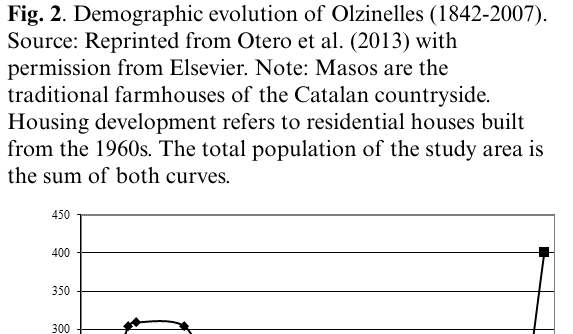
Fig. 2 . Demographic evolution of Olzinelles